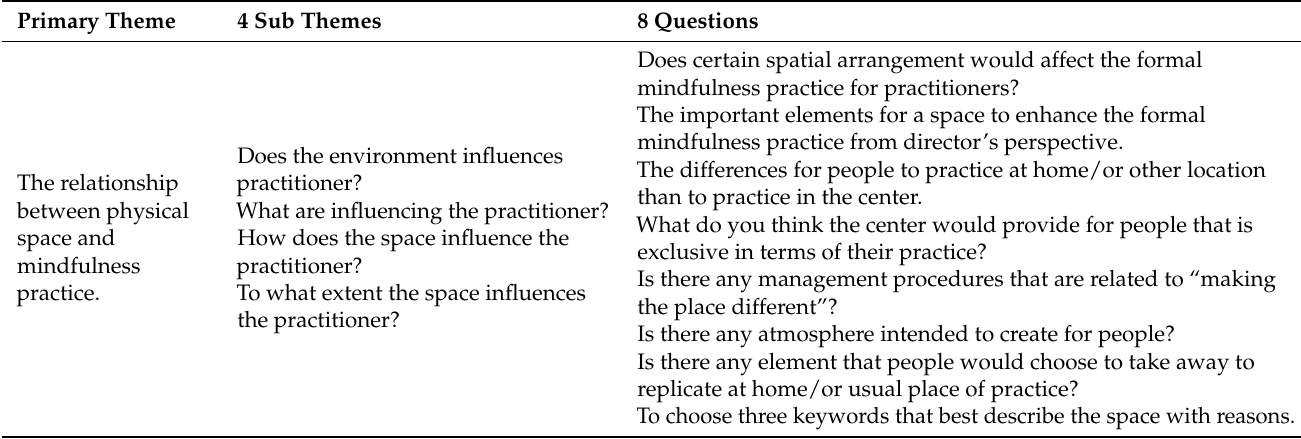
Table 1. Theme of SSI.